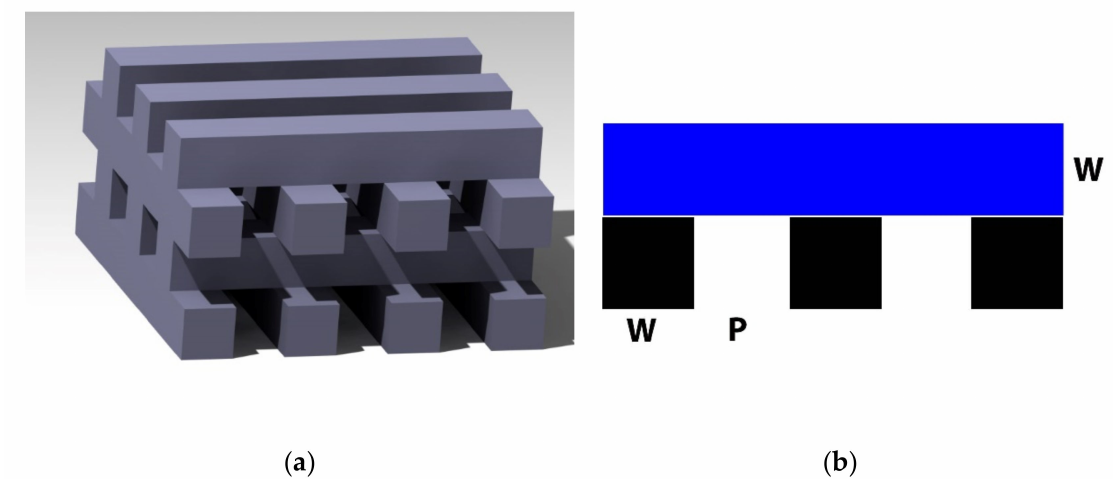
Figure 1. β -TCP Scaffolds; ( a ): 3D rendering from CATIA V5R19 (Dassault Systems, V é lizy-Villacoublay, France); ( b ): schematic sketch, W corresponds to the wall thickness of the sintered scaffold, which was varied from 1500–2500 µ m, P corresponds to the pore size, which was varied from 500–1000 µ m.